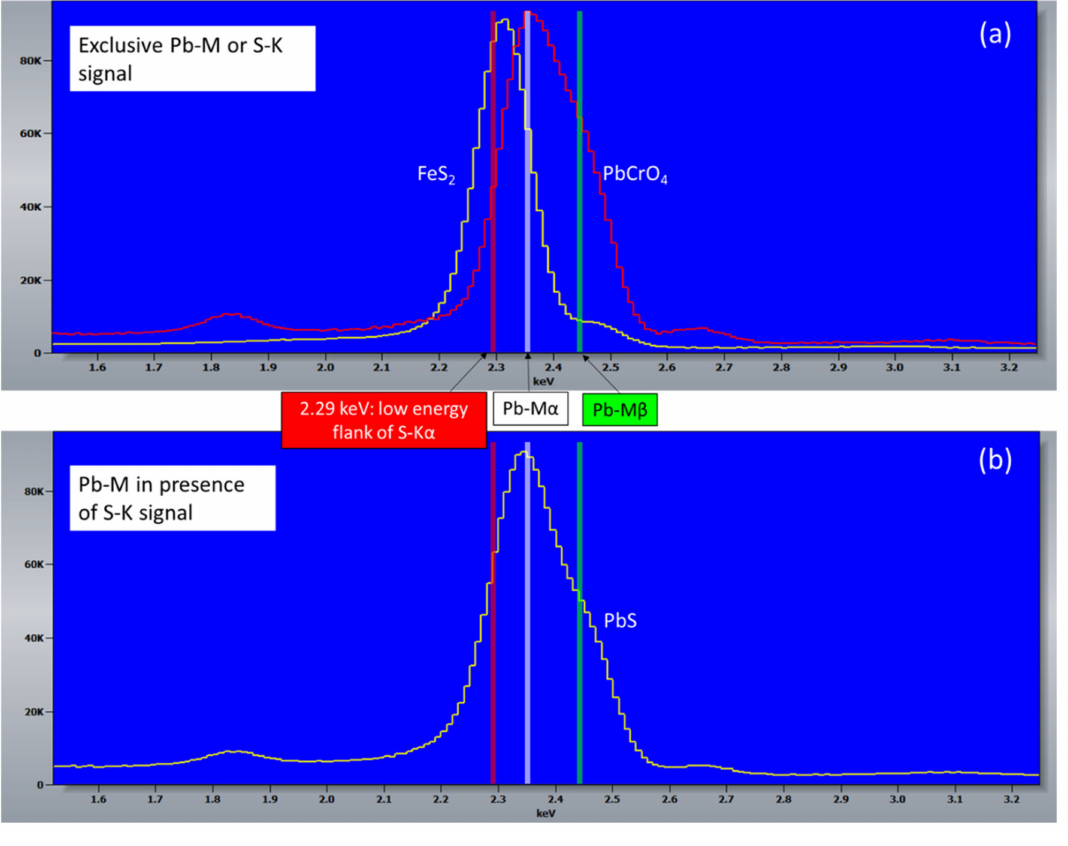
Figure 3. Illustration of differences in peak position and shape for ( a ) signal from S K-lines (on FeS 2 ) versus Pb M-lines (on PbCrO 4 ), versus ( b ) mixed signal of both (PbS). The three labelled vertical lines denote the three channels used for discrimination of Pb-rich pixels from S-rich, Pb-free pixels in Figures 4 and